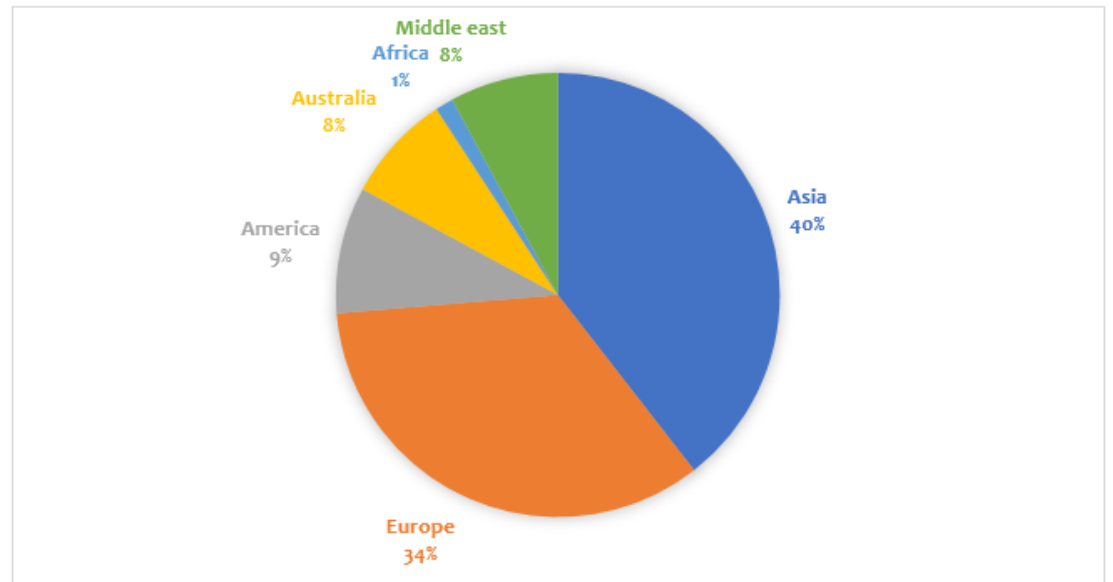
Figure 3. Distribution of the reviewed papers by region.